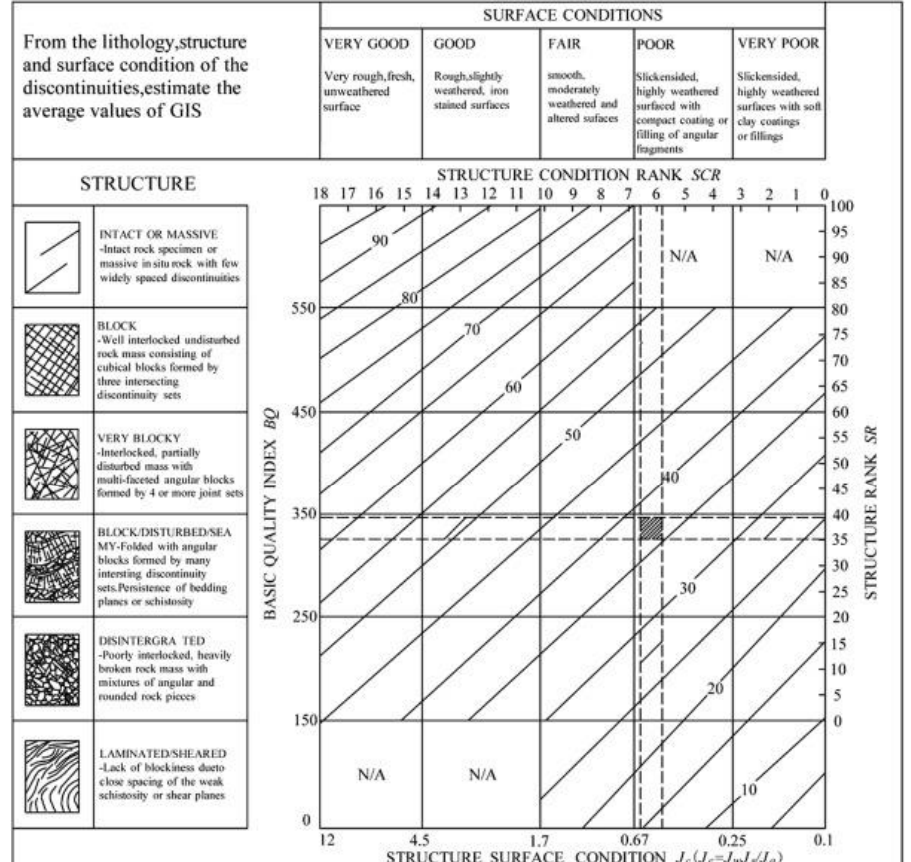
Figure A13. Quantified GSI chart [55].